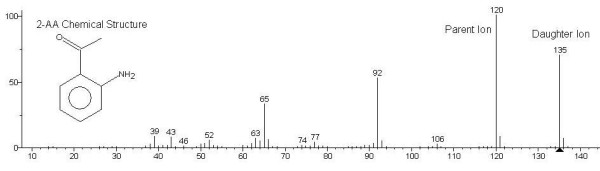
NIST library formula and mass spectra of 2-AA under EI conditions.